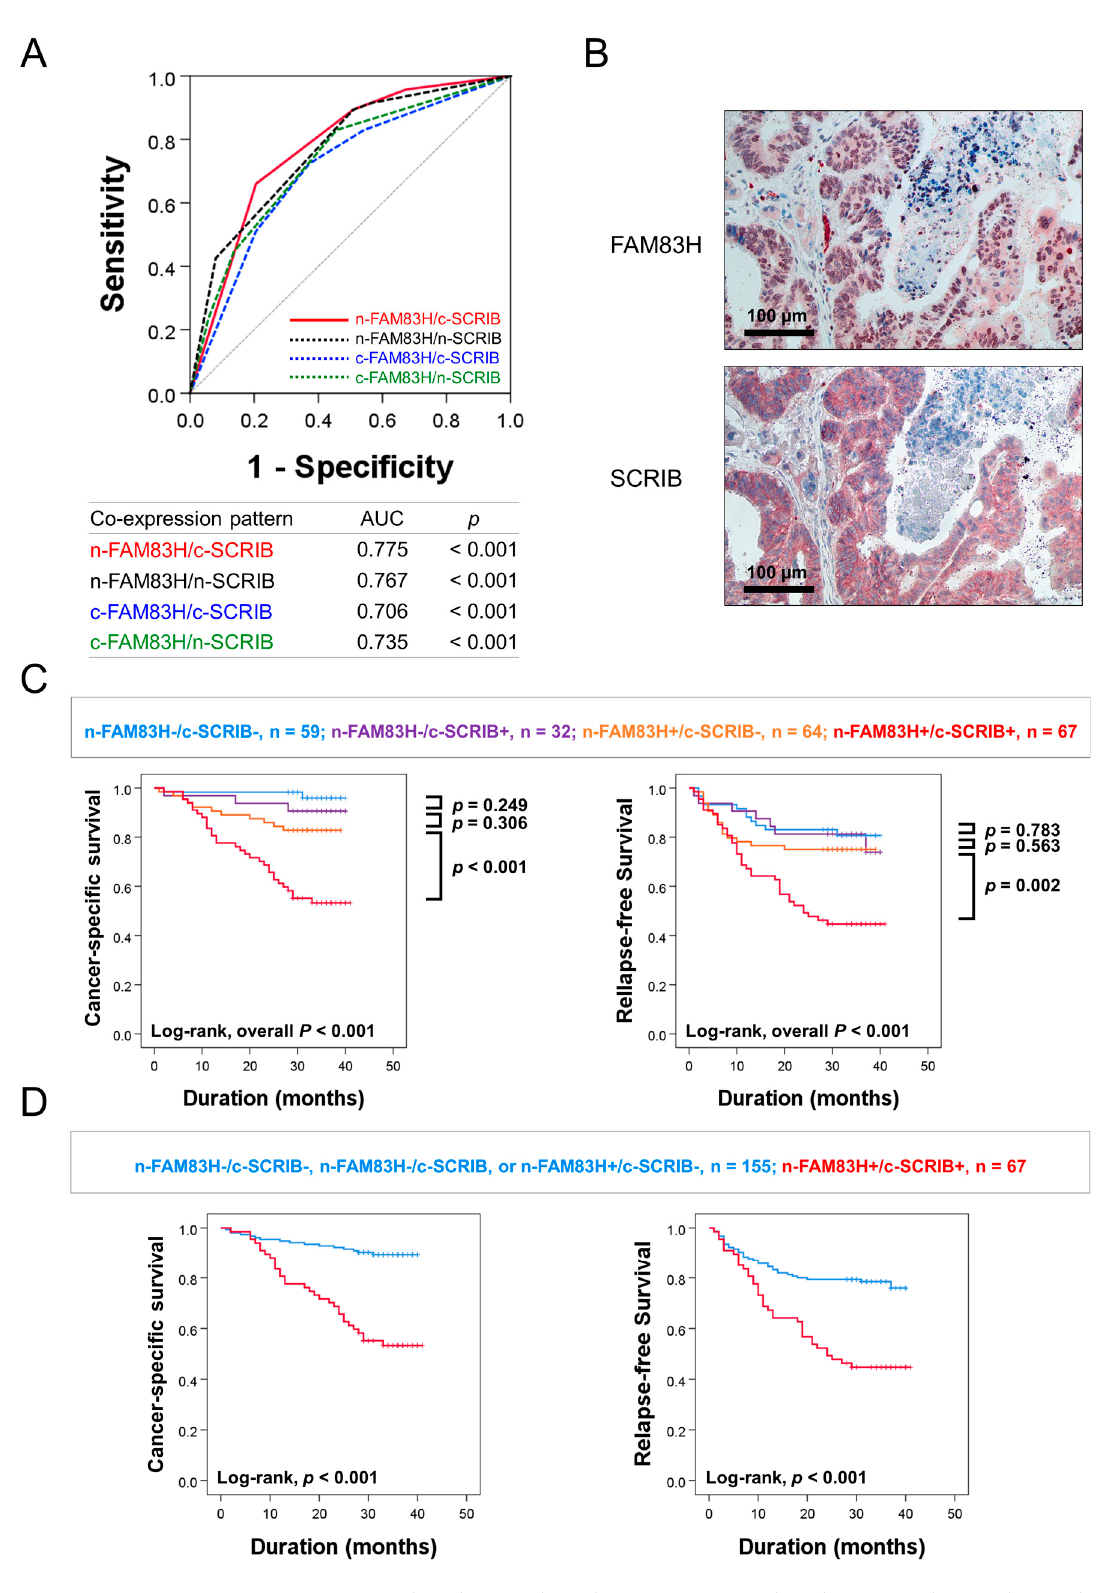
Figure 3. Statistical analysis and Kaplan–Meier survival analysis according to the combined expres- sion pattern of nuclear and cytoplasmic expressions of FAM83H and SCRIB. ( A ) Receiver operating characteristic curve analysis to predict the death of CRC patients according to combined expression patterns of nuclear and cytoplasmic expressions of FAM83H and SCRIB: n-FAM83H/c-SCRIB, n-